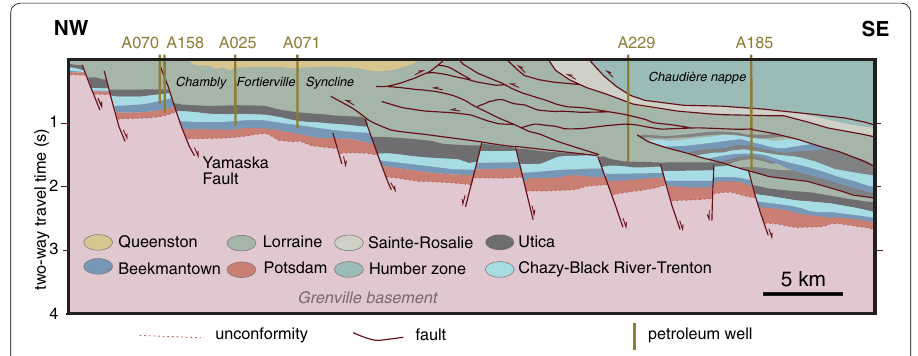
Fig. 3 Interpretation of seismic profile M2002. Interpretation of seismic profile M2002 crossing the modeled region (simplified from Castonguay et al. (2010). Bottom hole temperatures after Harrison correction in °C for wells A070, A229 and A185 are shown in the profile